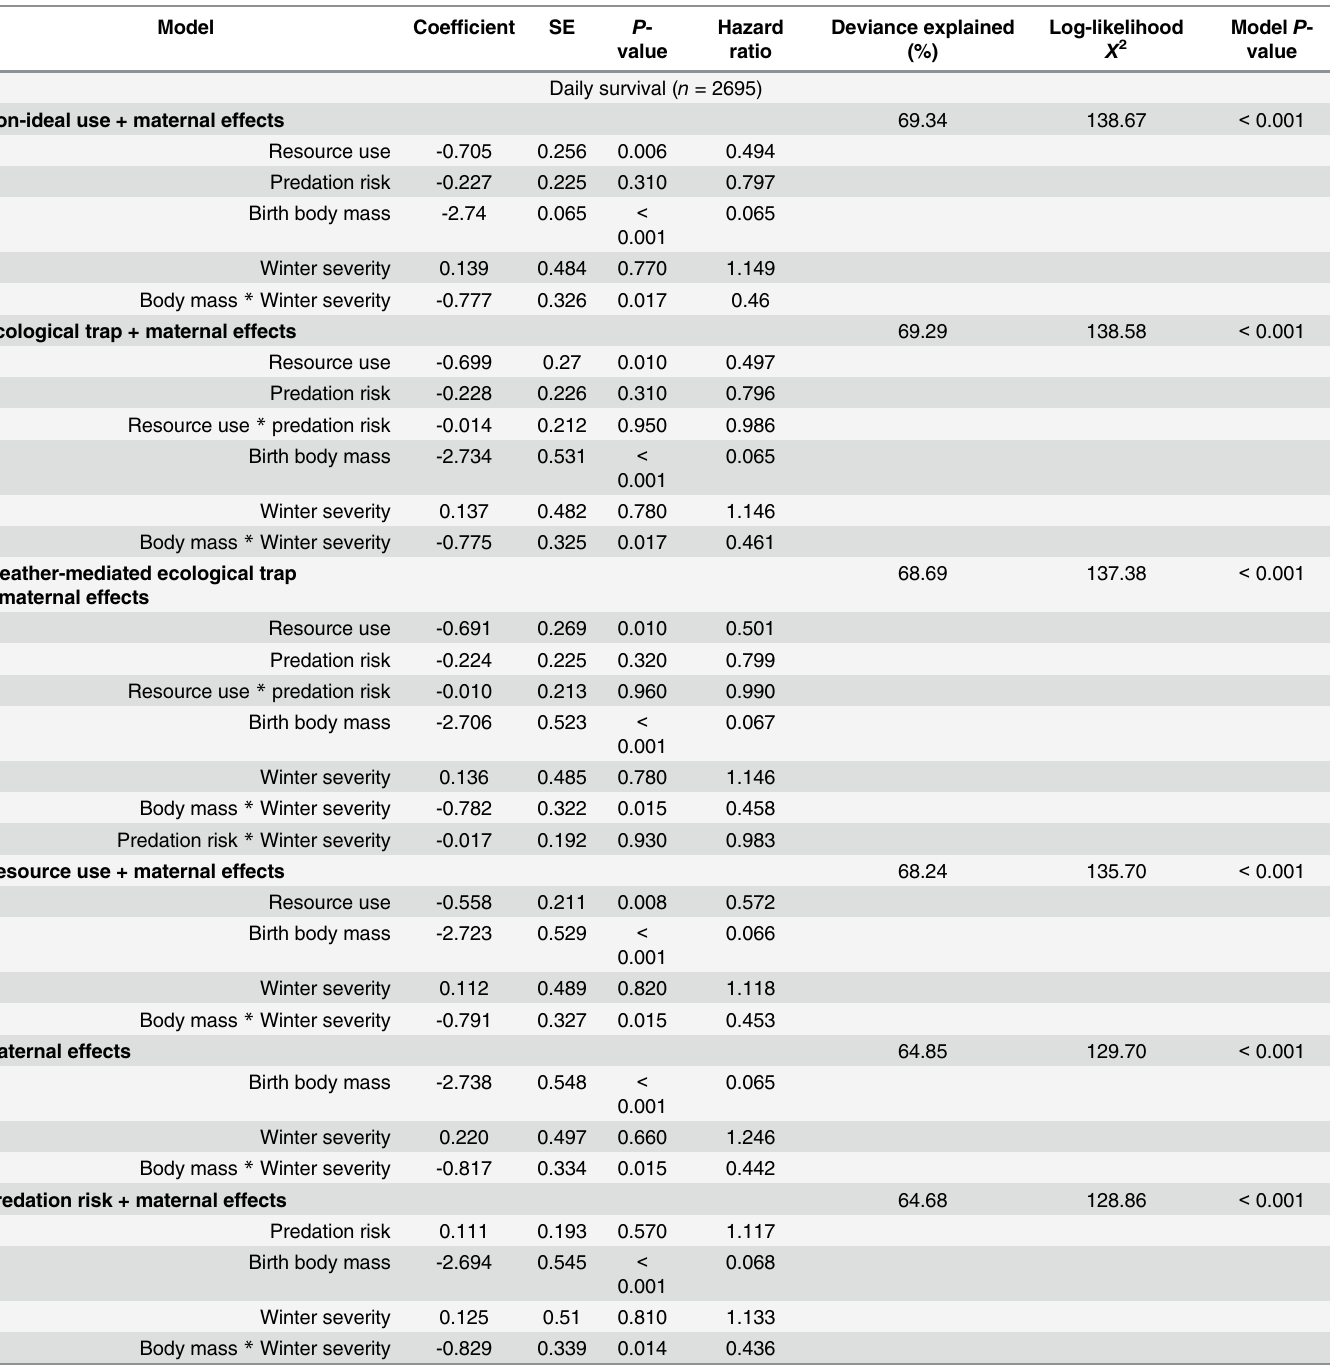
Table 4. Cox-proportional hazards mixed-effects models assessing the effects of resource use, predation risk, birth body mass, winter severity, and vegetation hiding cover on the daily or seasonal survival of white-tailed deer fawns ( (cid:1) 14 weeks of age; n = 129) during the post-partum period (14 May – 31 Aug), Upper Peninsula of Michigan, USA, 2009 – 2011. Models included individual fawn and year as random effects on the intercept. Models presented with standardized parameter estimates, standard errors (SE), coefficient probability values, degrees of freedom ( df ), and estimated hazard ratio parameter probability values, and percent integrated deviance explained indicating the reduction in the log-likelihood from the null model. Percent deviance explained was used to rank models. Model fit was assessed using a Chi-square test of log-likelihood of a given model (Log-likelihood X 2 ) compared to the null